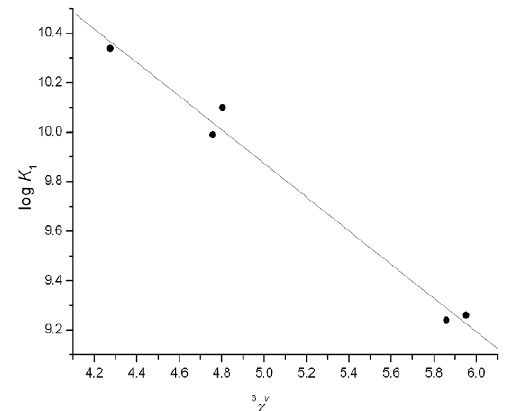
Figure 2. Experimental log K vs. 3 χ v index for Ni(II) N -salicylidene- 1 aminoacidato mono -complexes (Model 1, Table 2).